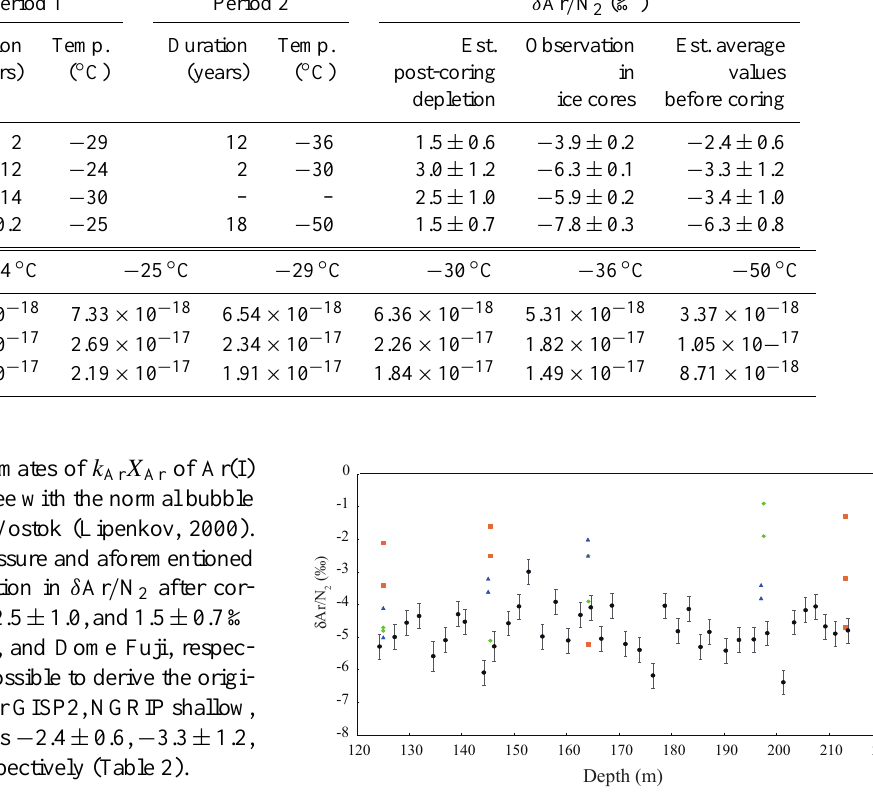
Figure 3. Comparison of δ Ar / N 2 for shallow GISP2 cores (124– 214m) measured in different periods. Color data points (blue tri- angles, orange squares, and green diamonds) are individual data from Bender et al. (1995), and black data points with error bounds are from Kobashi et al. (2008b). We did not use shallower data of Bender et al. (1995) as they exhibit depletions similar to our shallow NGRIP data (Fig. 8); an anomalous value ( − 16.91‰ at 145.4m) in the Bender data set was also excluded. Squares, dia- monds, and triangles represent the data measured after 1 week, 3 months, and 7 months of coring, respectively (Bender et al., 1995). The average difference between the Kobashi and Bender data sets is − 1.51 ± 0.58‰, which we interpret as the post-coring fractiona- tion for